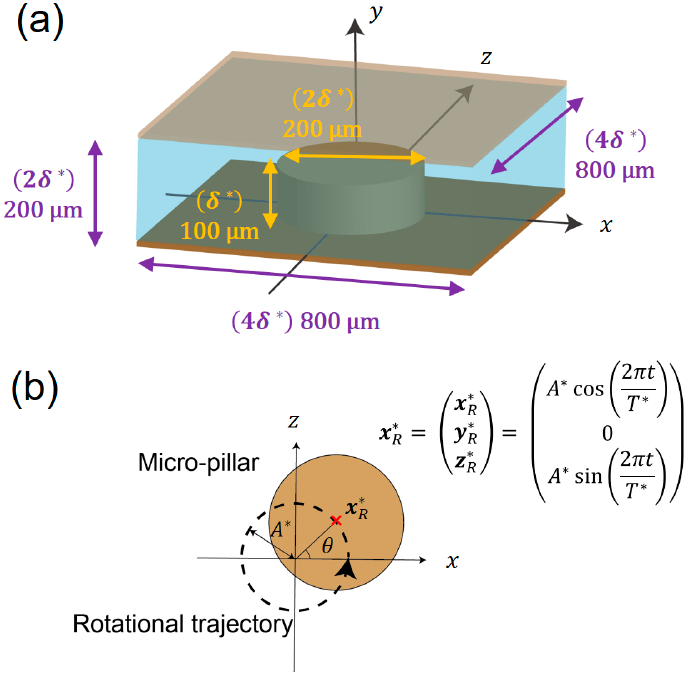
Figure 1. ( a ) Schematic of coordinate system and computational domain. ( b ) Circular vibration of the micro-pillar.